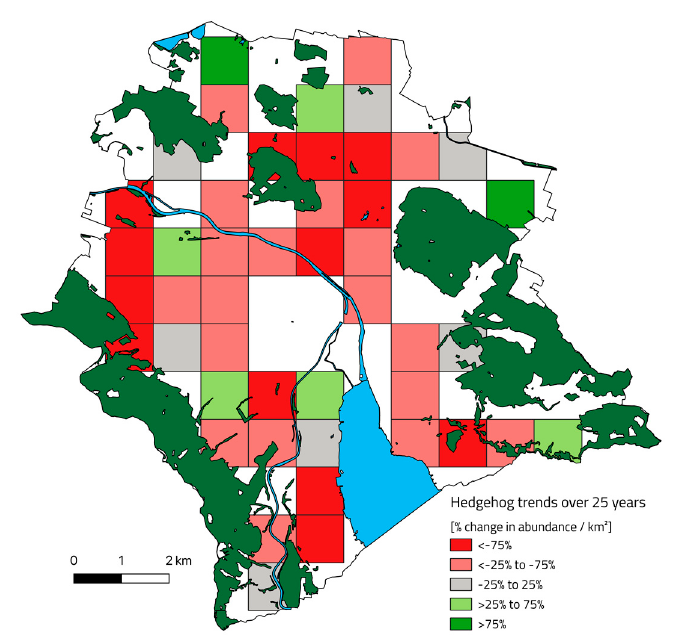
Figure 3. Changes in hedgehog abundance estimates between the past (1992) and recent (2016–2018) study (% change in abundance / km 2 ). The outline delineates the municipal border of the city of Zurich with forest area (green) and water bodies (blue). Squares signify the study area divided into km 2 : declining hedgehog abundance (red), increasing hedgehog abundance (green).